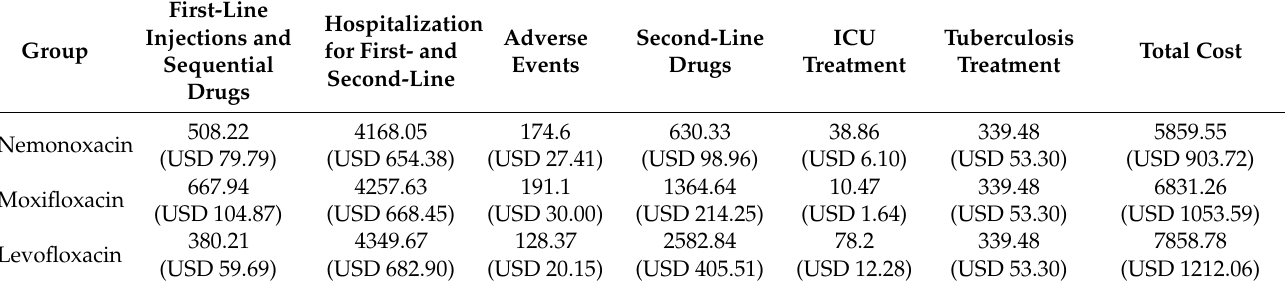
Table 3. Breakdown for basic analysis costs (CNY).